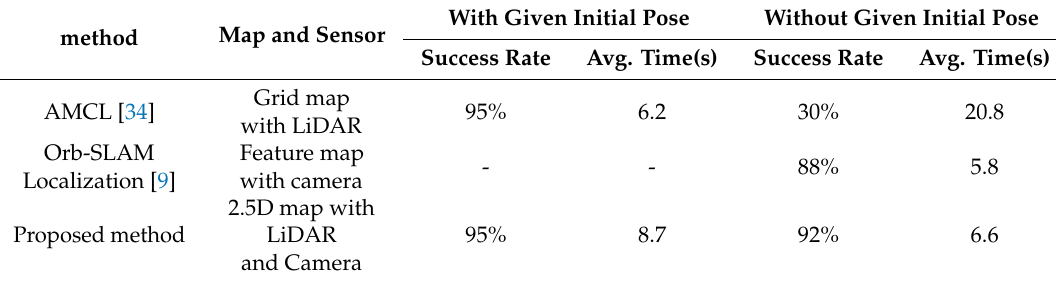
Table 3. The relocation results of a di ff erent